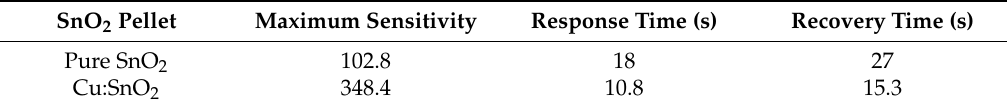
Figure 9. Gas-sensing mechanism of the pure SnO 2 in ( a ) air and ( b ) CO; and Cu:SnO 2 pellets in ( c ) air and ( d ) CO.